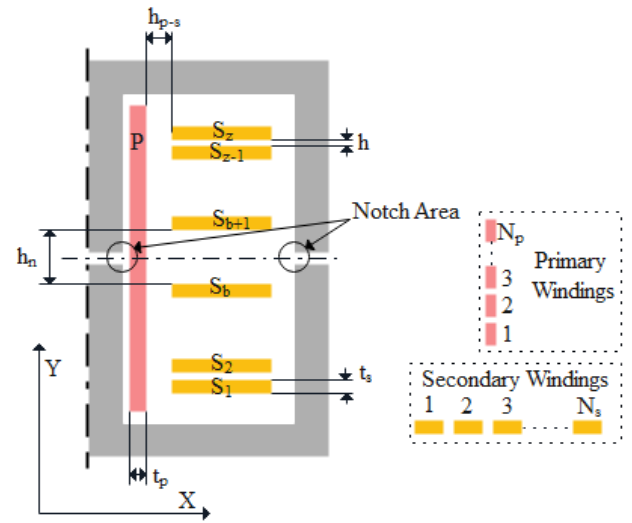
Figure 11. Proposed winding arrangement.